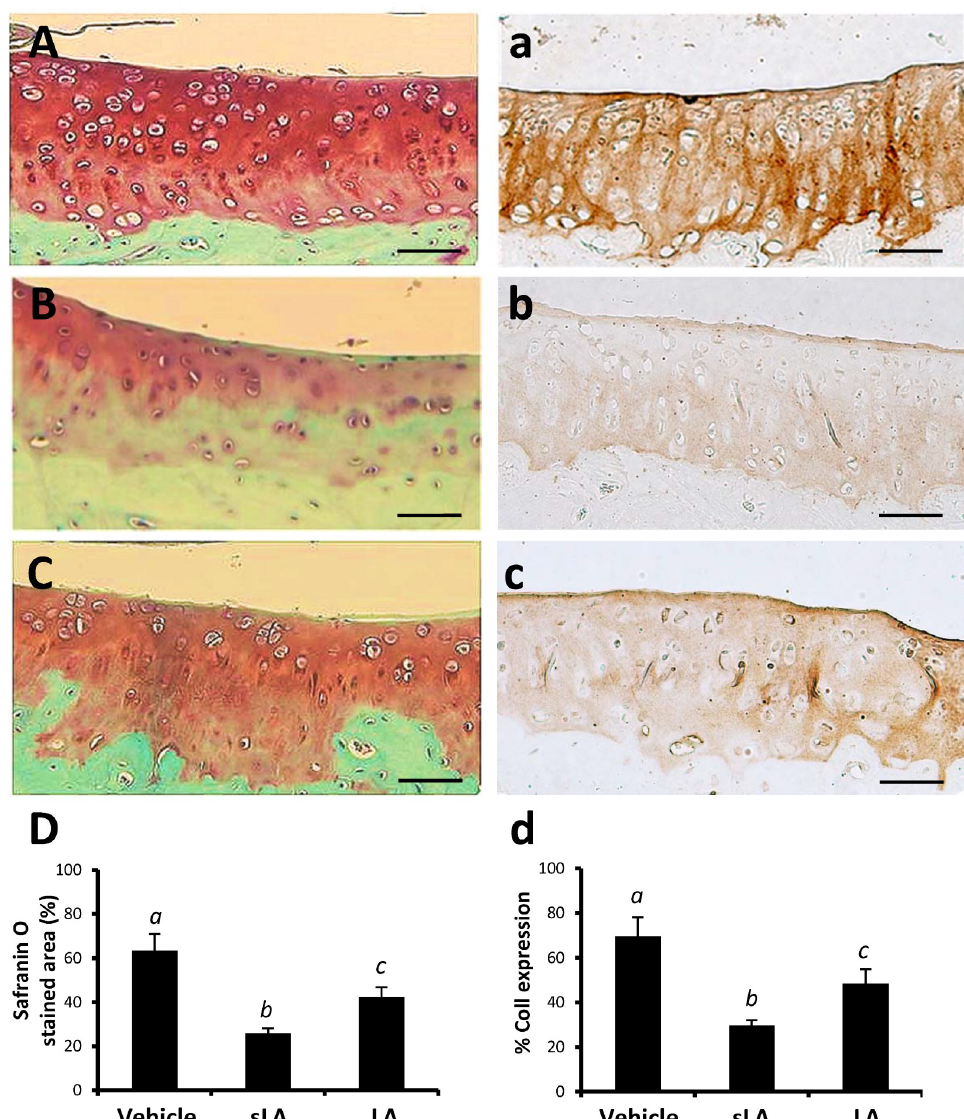
Fig 4. Representative images of surface cartilage damage at the tibial plateau with collagen type II (CoII) immunoreactivity and safranin O/Fast Green staining in vehicle control (A and a), CFA combined with sham- operation (sLA, Band b) and laser acupuncture (LA, C and c) (sLA and LA) groups, respectively. At higher-power magnification, it is evident that marked increase of positive collagen type II immunoreactivities (brown staining) and proteoglycan safranin O (dark orange) were clearly localized in the LA group compared with sLA. Quantitative analysis of positive-labeled cells in cartilage for safranin O (D) and collagen type II immunohistochemistry (d) in each group was presented in mean ± SD. Different italic letters ( a , b , c )indicate significant differences between groups using Scheffe’s post hoc test (P < 0.05). A scale bar indicates 50 μ m.